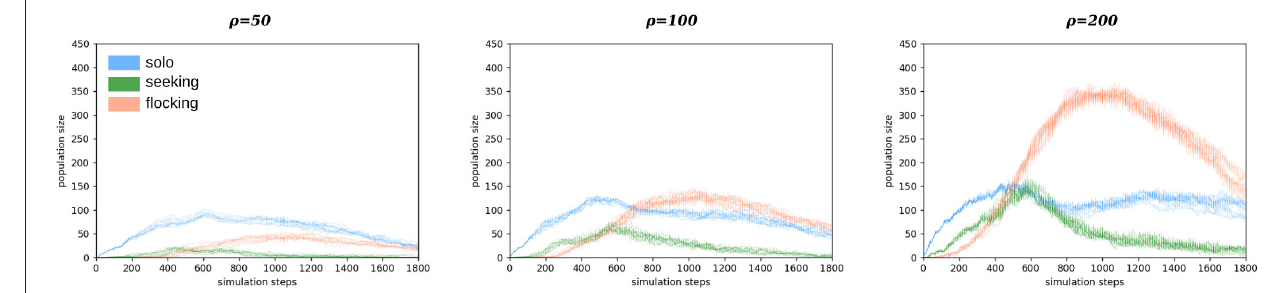
FIGURE 3 | Population sizes for agents in different states for three densities, from left to right: ρ = 50, ρ = 100, ρ = 200. Blue curves depict solo riders, green curves represent the population of agents riding toward a flock, red curves represent the population size of flocking agents. Each plot shows 20 repetitions of a simulation run for the same density.